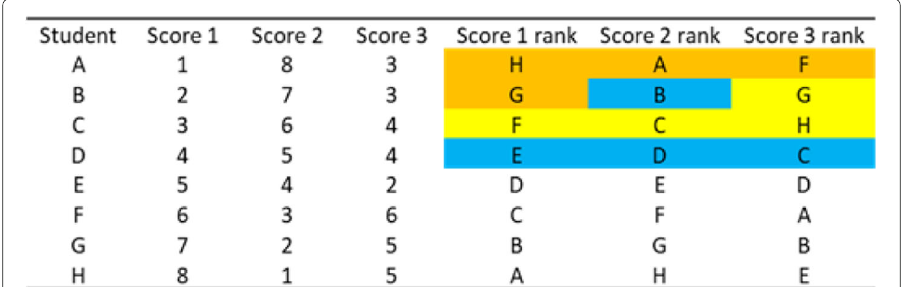
Fig. 5 Demonstration of an example of jigsaw